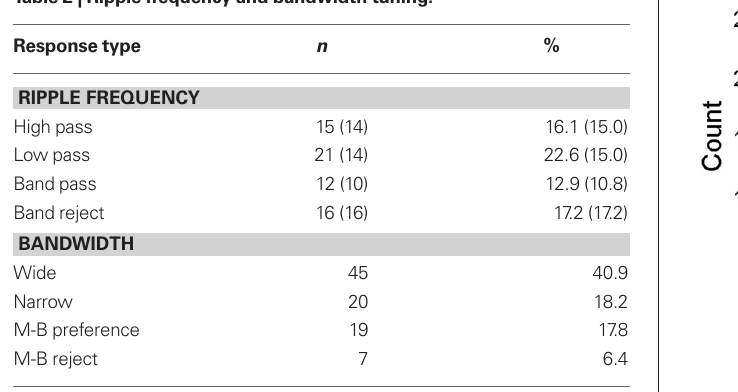
in parentheses are the numbers of neurons classified on the basis of function fits (see Section “Results” for further explanation). M-B, mid-bandwidth.